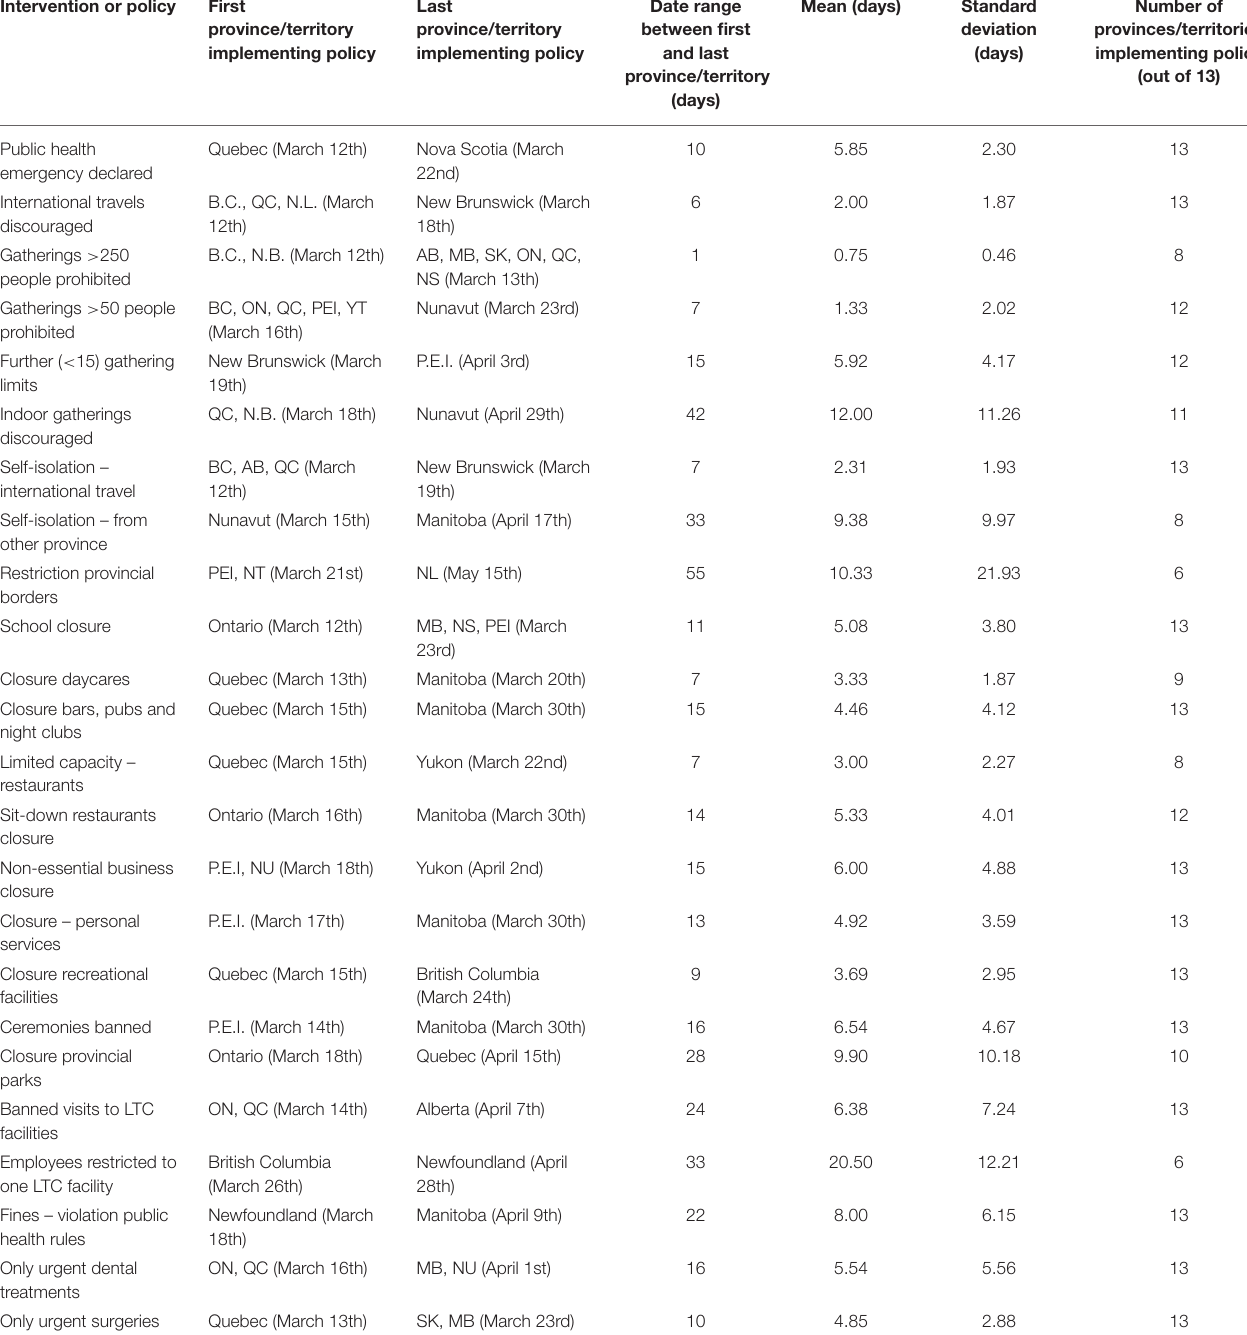
TABLE 1 | Public health interventions during the early COVID-19 pandemic analyzed by date of implementation. Intervention or policy First